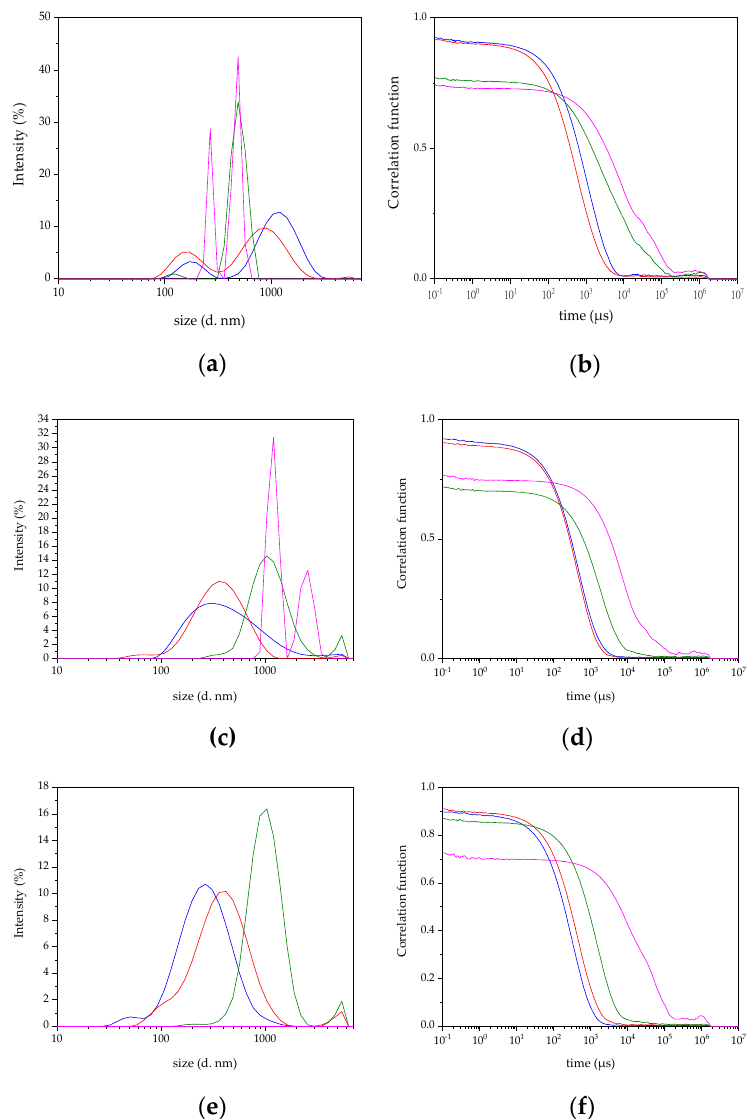
Figure 5. Size analyses of the nanostructures obtained after adding blank o/w NCs to mucin solutions at mucin:B o/w NC ratios of 0.08 ( w/w ) (pink), 0.17 ( w/w ) (green), 0.34 ( w/w ) (red), and 0.67 ( w/w ) (blue): ( a ) Comparison of hydrodynamic diameter and ( b ) correlogram functions of the suspensions at time 0 h; ( c ) comparison of hydrodynamic diameter and ( d ) correlogram functions of the suspensions after 1 h of incubation at 37 °C; ( e ) comparison of hydrodynamic diameter and ( f ) correlogram functions of the suspensions after 24 h of incubation at 37 °C.